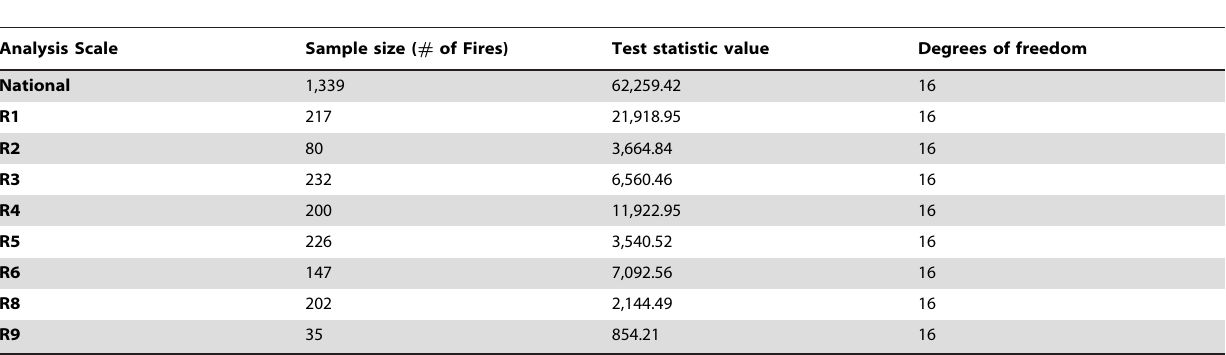
Table 5. Results of likelihood ratio statistical tests for null hypothesis that chain is of order 0 against alternative hypothesis that chain is of order 1.